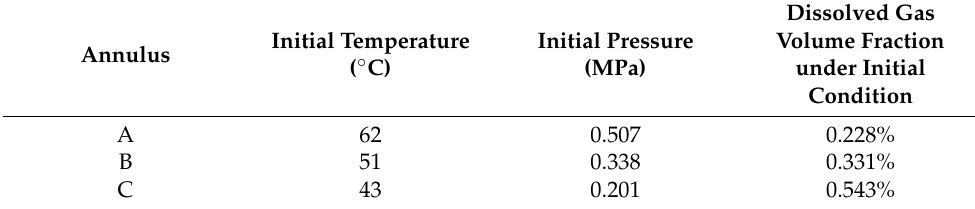
Table 5. The initial condition of fluid in each annulus.